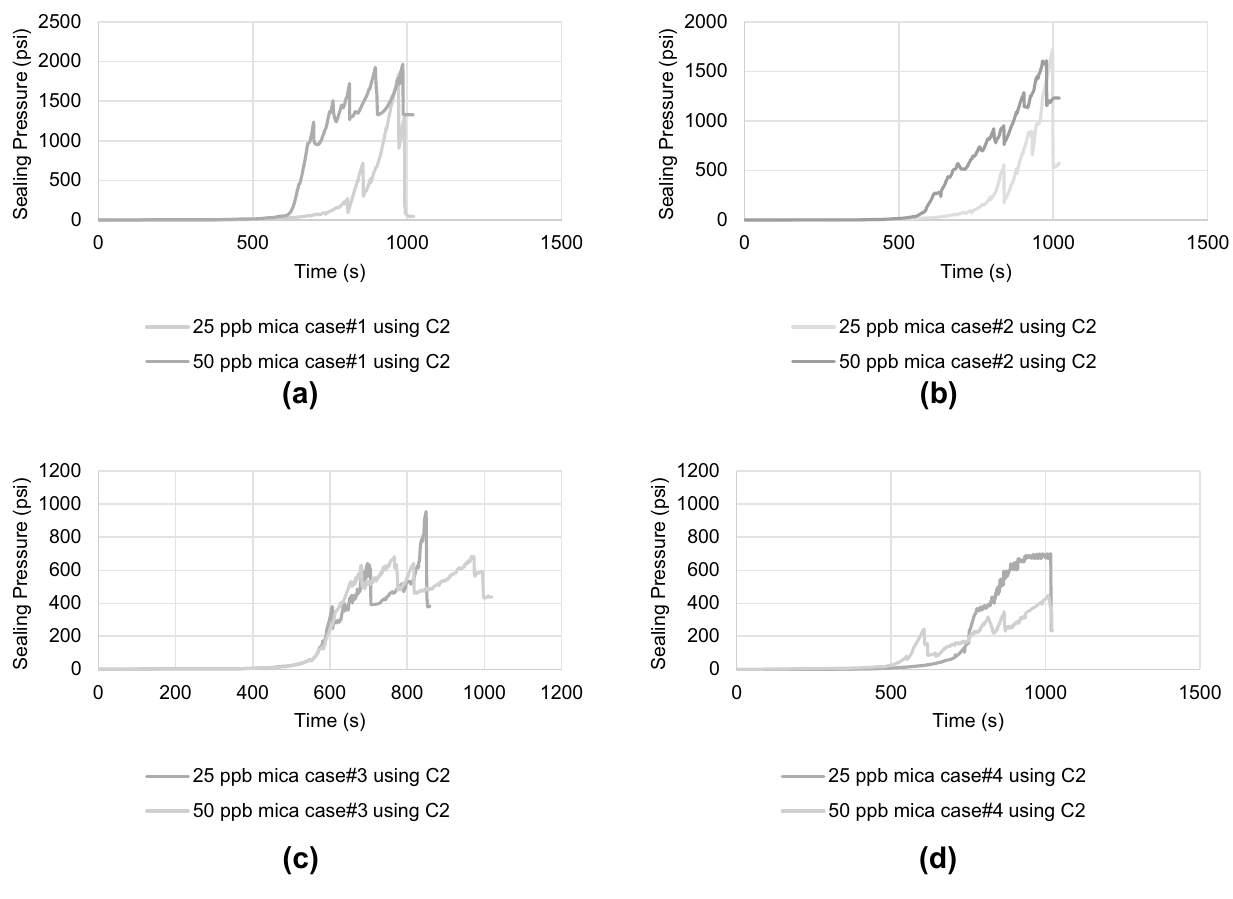
Fig. 13 HPA Pressure versus Time plot for Mica showing maximum sealing pressure at different concentrations, a case#1, b case#2, c case#3,